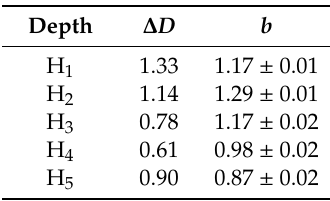
Table 1. ∆ D and b values at di ff erent